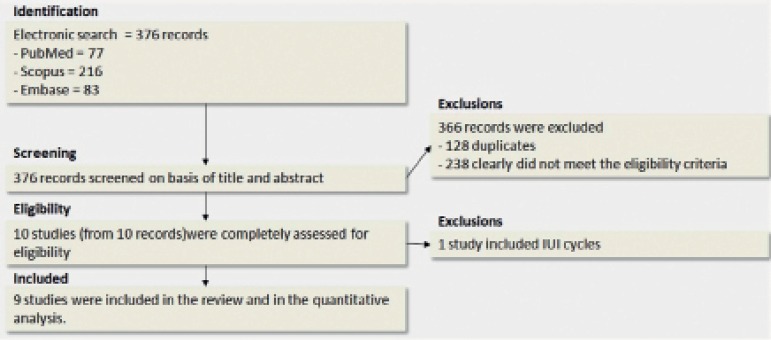
Flowchart of study selection.